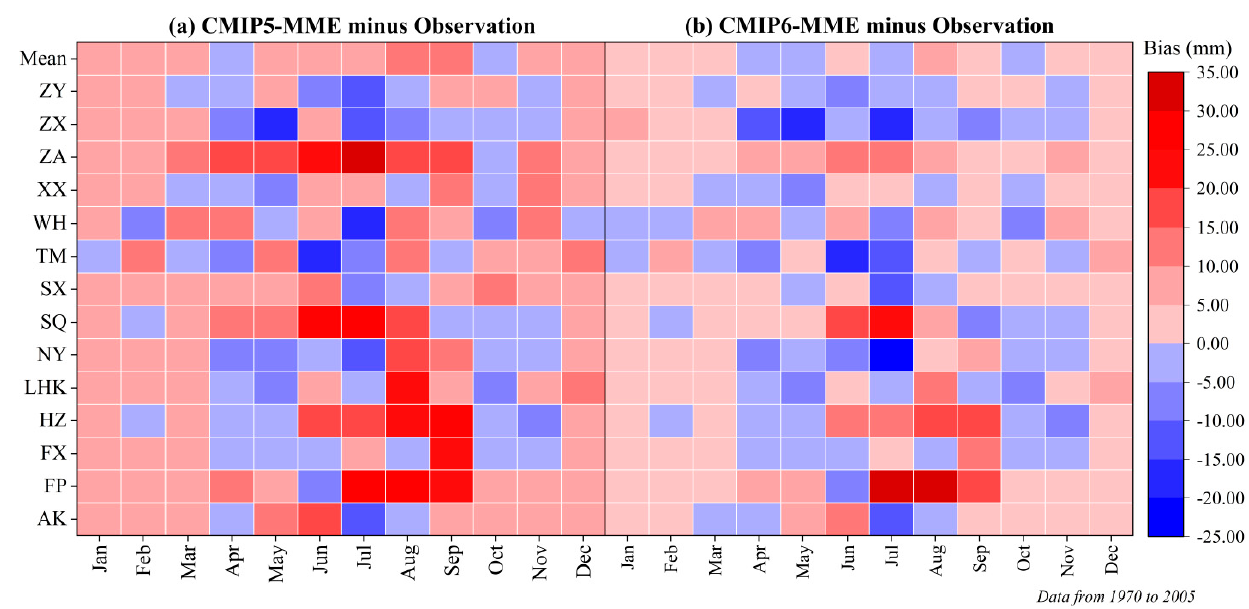
Figure 8. Box and scatter plots of average monthly precipitation of CMIP5-MME downscaled data, CMIP6-MME downscaled data, and observed data for each month from 1970 to 2005.